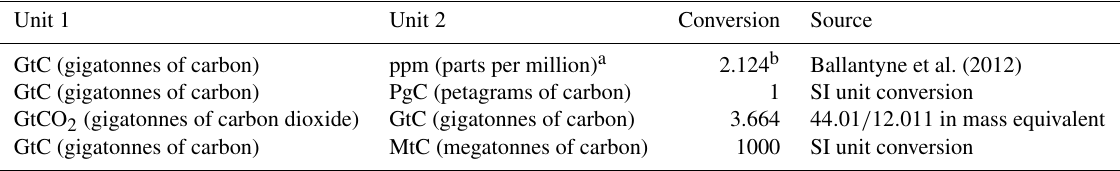
Table 1. Factors used to convert carbon in various units (by convention, Unit 1 = Unit 2